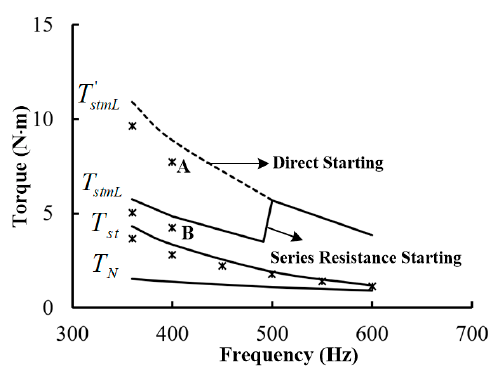
Figure 10. The data comparison of simulation and experiment.